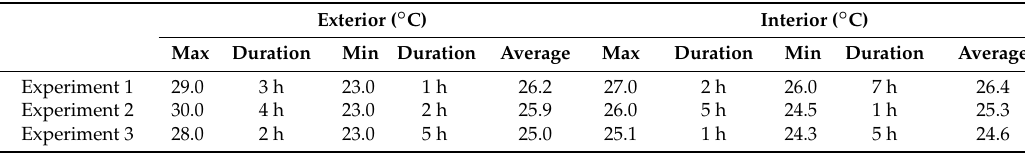
Table 5. Comparison of space temperature in each experiment.